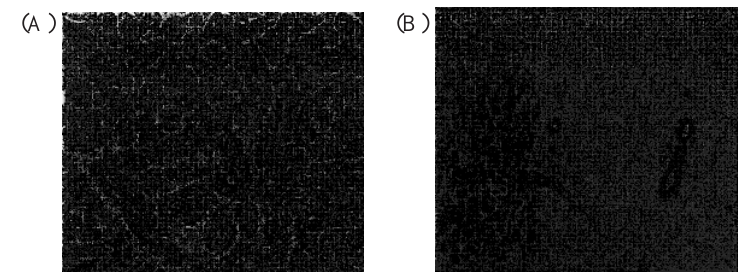
Fig. 1. Section of pancreas stained for chromogranin. Tissue was fixed in (A) Histochoice or (B) NBF (DAB chromogen, 100 × ). Histochoice produced a more intense stain. Note staining of the acinar cells with both fixatives.